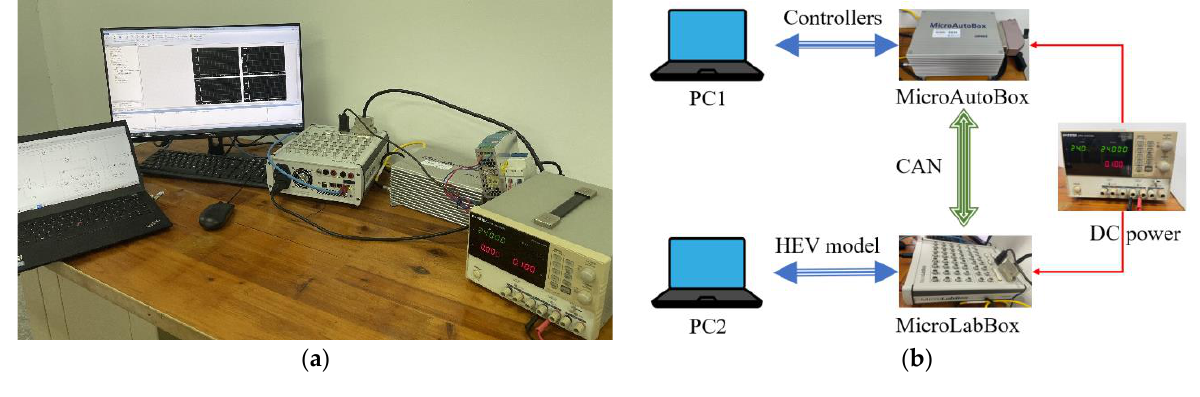
Figure 17. HIL ( a ) test platform and ( b ) schematic.